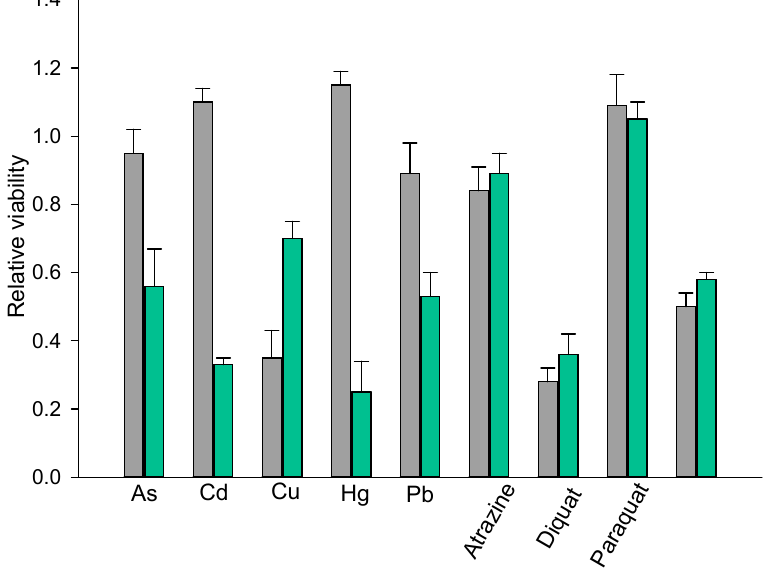
Figure 9. Viabilities of NRK-52E cells treated with common environmental nephrotoxic pollutants (gray bars) and co-treated with 1 mM β -CEC (green bars) for 18 h. Concentrations of the pollutants: NaAsO 2 —15 µ M; CdCl 2 —30 µ M; CuCl 2 —480 µ M; HgCl 2 —30 µ M; Pb(OAc) 2 —1.2 mM; atrazine, diquat, and paraquat—300 µ M; ochratoxin A—30 µ M. Statistical significances ( n = 3, p < 0.001) are marked with asterisks. See Supplementary Materials Table S18 for extended